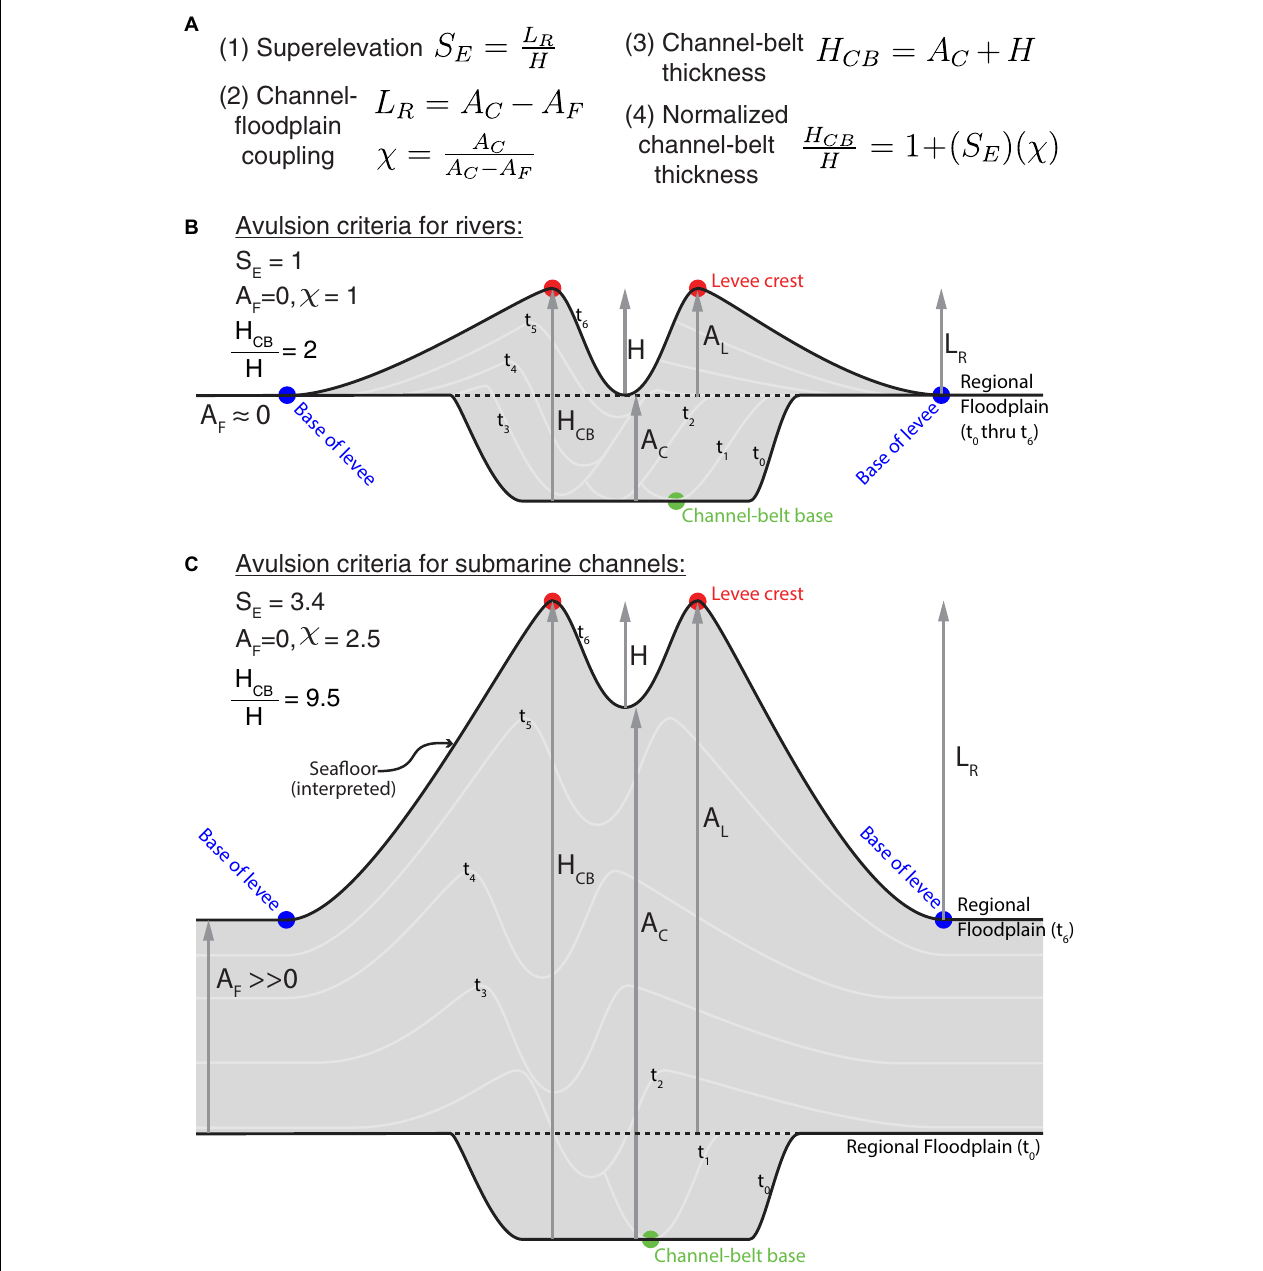
FIGURE 1 | Fluvial and submarine channel-belt metrics for measuring aggradation and determining avulsion criteria. (A) Governing equations (see text for explanation of terms). (B) Fluvial channel-belt diagram and avulsion criteria. (C) Submarine channel diagram and avulsion criteria. Submarine channels can be up to 10 times thicker than rivers at avulsion due to enhanced superelevation and channel-floodplain